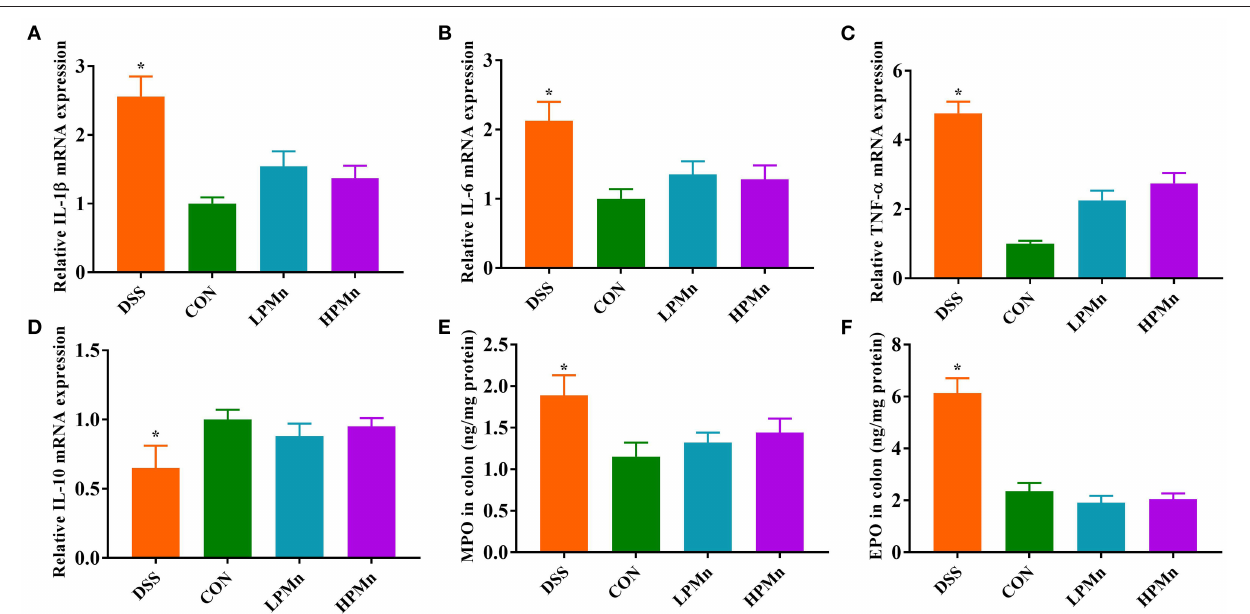
FIGURE 2 | Ulva polysaccharide-manganese improved inflammatory response and colonic infiltration. Relative mRNA expression of IL-1 β (A) , IL-6 (B) , TNF- α (C) and IL-10 (D) . Colonic concentration of MPO (E) and EPO (F) . Values are expressed as mean ± SEM, n = 7. * P < 0.05 (Significant difference between DSS group and other three